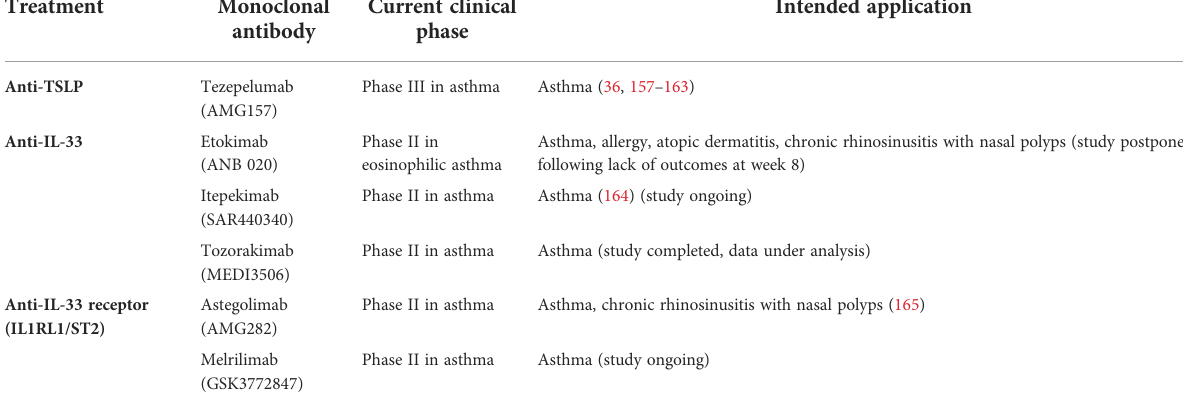
TABLE 1 Clinical trials of drugs targeting alarmins in asthma.